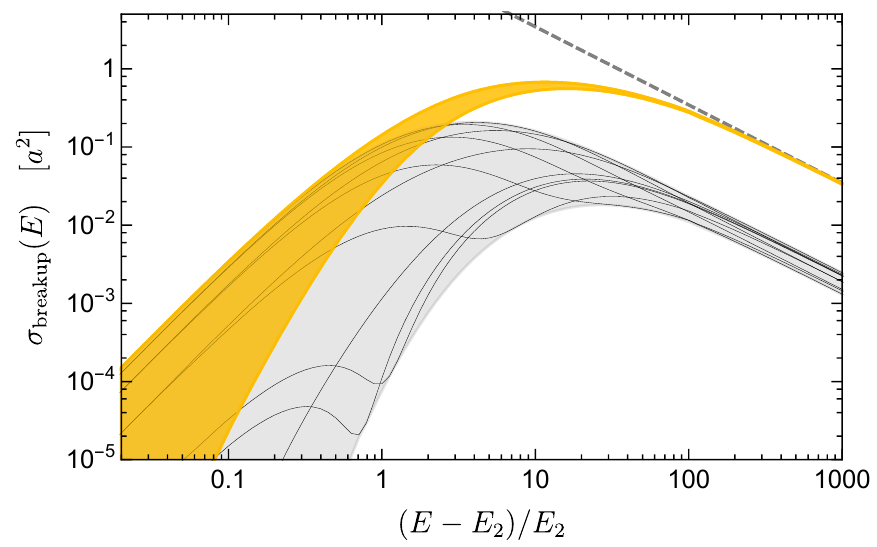
Figure 2 . The breakup cross section as a function of energy with respect to the threshold: E (cid:0) E 2 . The upper band is the envelope of (cid:27) breakup ( E ) for all possible values of the three-body parameter a + . The lower band is the envelope of the J = 0 contribution to (cid:27) breakup ( E ) for all possible values of a + . The curves inside the lower band are for 8 values of a + : a + =a = (cid:21) n= 8 dashed line is the extrapolation from the scaling behavior in eq.